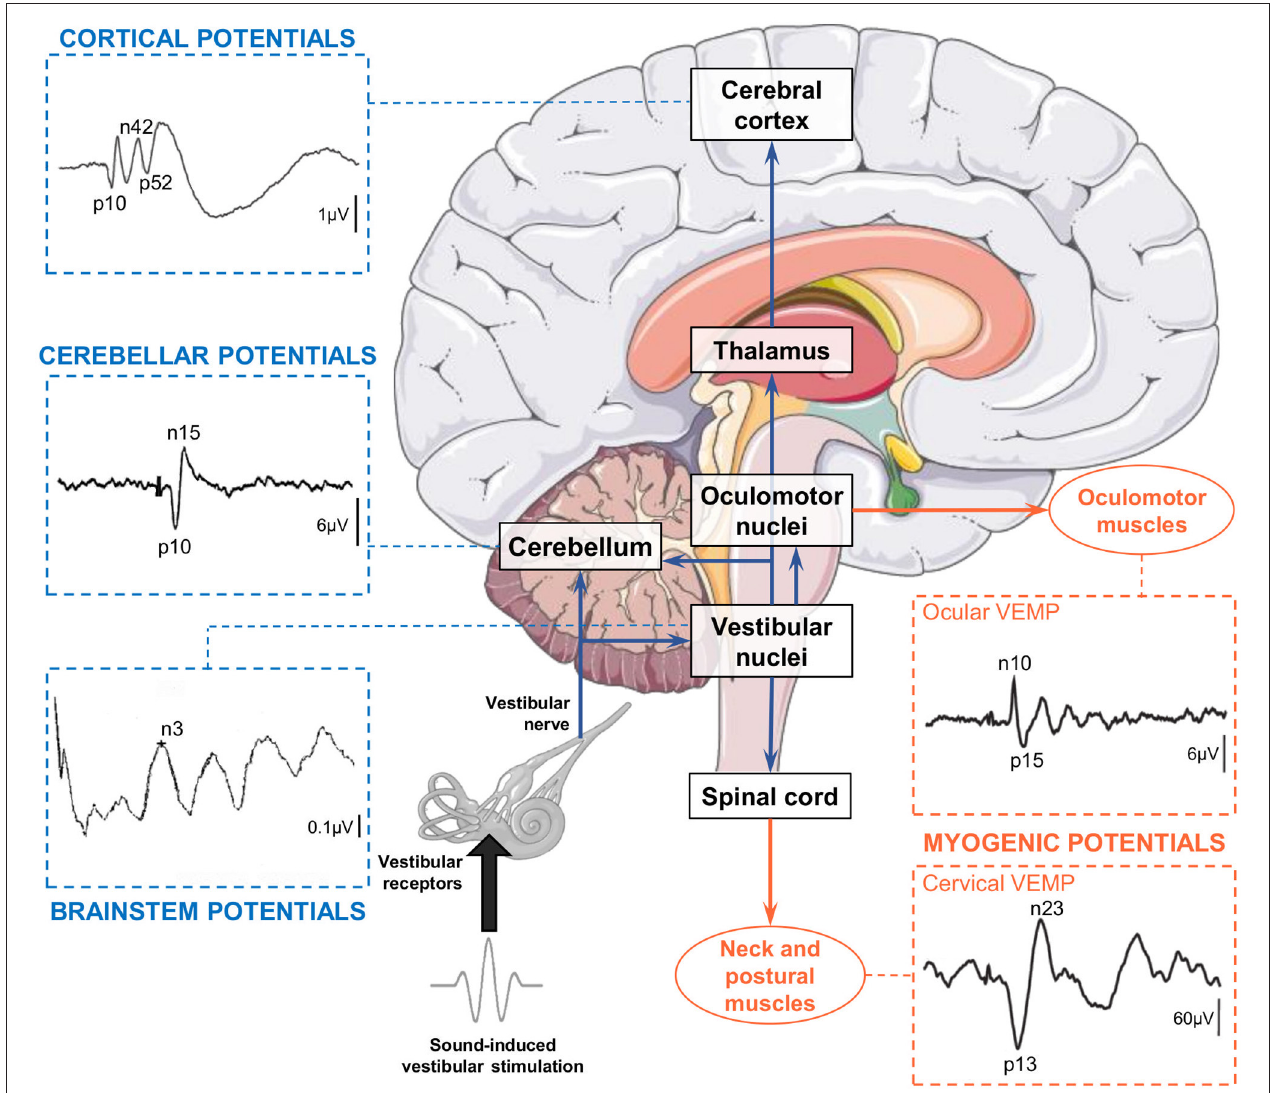
FIGURE 1 | Electrical potentials evoked by sound-induced vestibular stimulation can be recorded along the pathways from the otolithic receptors to the central nervous system and muscles. Vestibular-evoked myogenic potentials (VEMPs) are recorded over extraocular, neck, and postural muscles. Cervical VEMPs reflect an inhibitory reflex and are recorded with electrodes over the sternocleidomastoid muscle ipsilateral to the stimulation. Ocular VEMPs reflect an excitatory reflex and are recorded with electrodes placed over the inferior oblique muscle contralateral to the stimulation. Both traces are adapted from (39). Vestibular-evoked cerebral potentials (VestEPs) are recorded from electrodes placed on the scalp or neck. Brainstem potentials are characterized by an n3 component observed under electrode P3 [this example recorded in a healthy participant is adapted from (40)]. Cerebellar potentials: Grand mean evoked potentials showing probable cerebellar components p10 and n15 observed under electrode P08 [illustration adapted from cf. Govender et al. (41) with permissions from Springer Nature]. Cortical potentials: Grand mean evoked potentials showing components p10, n42 and p52 observed under electrode FCz [illustration adapted from (42)]. Brain illustration from Servier Medical Art